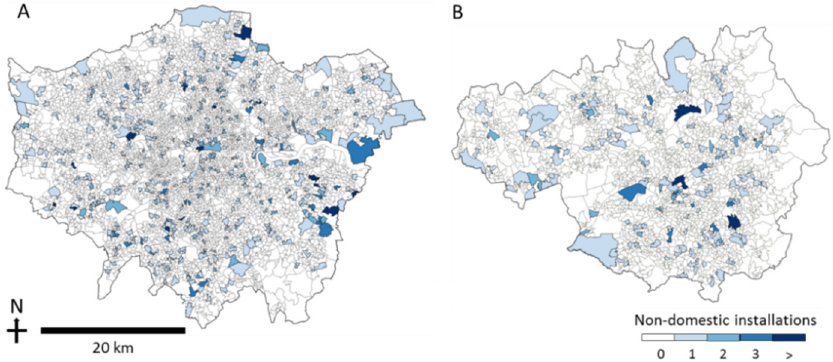
Figure 10. Non ‐ domestic PV deployment in urban case studies, ( A ) Greater Manchester and ( B ) Greater London.